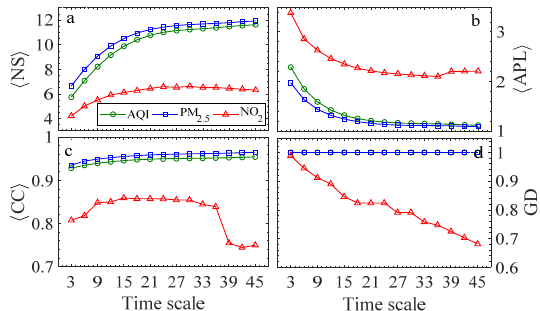
Figure 5. The four networks’ properties to different time scales for the AQI, PM 2.5 , and NO 2 series. ( a – d ) is <NS>, <APL>, <CC>, and GD, respectively.